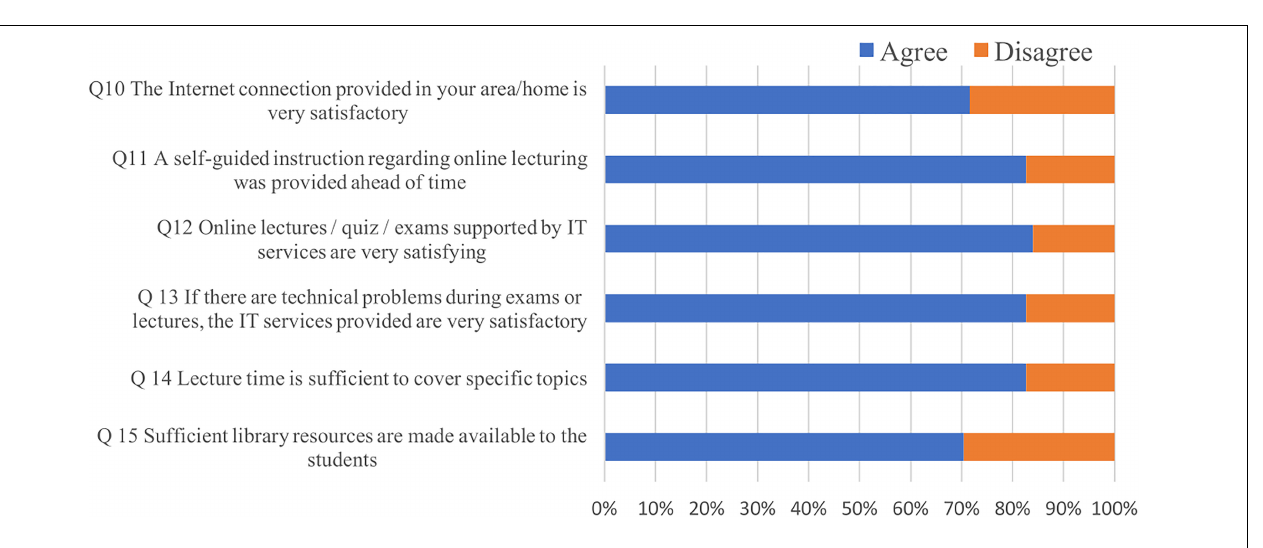
FIGURE 2 | Student’s satisfaction with technical support for online